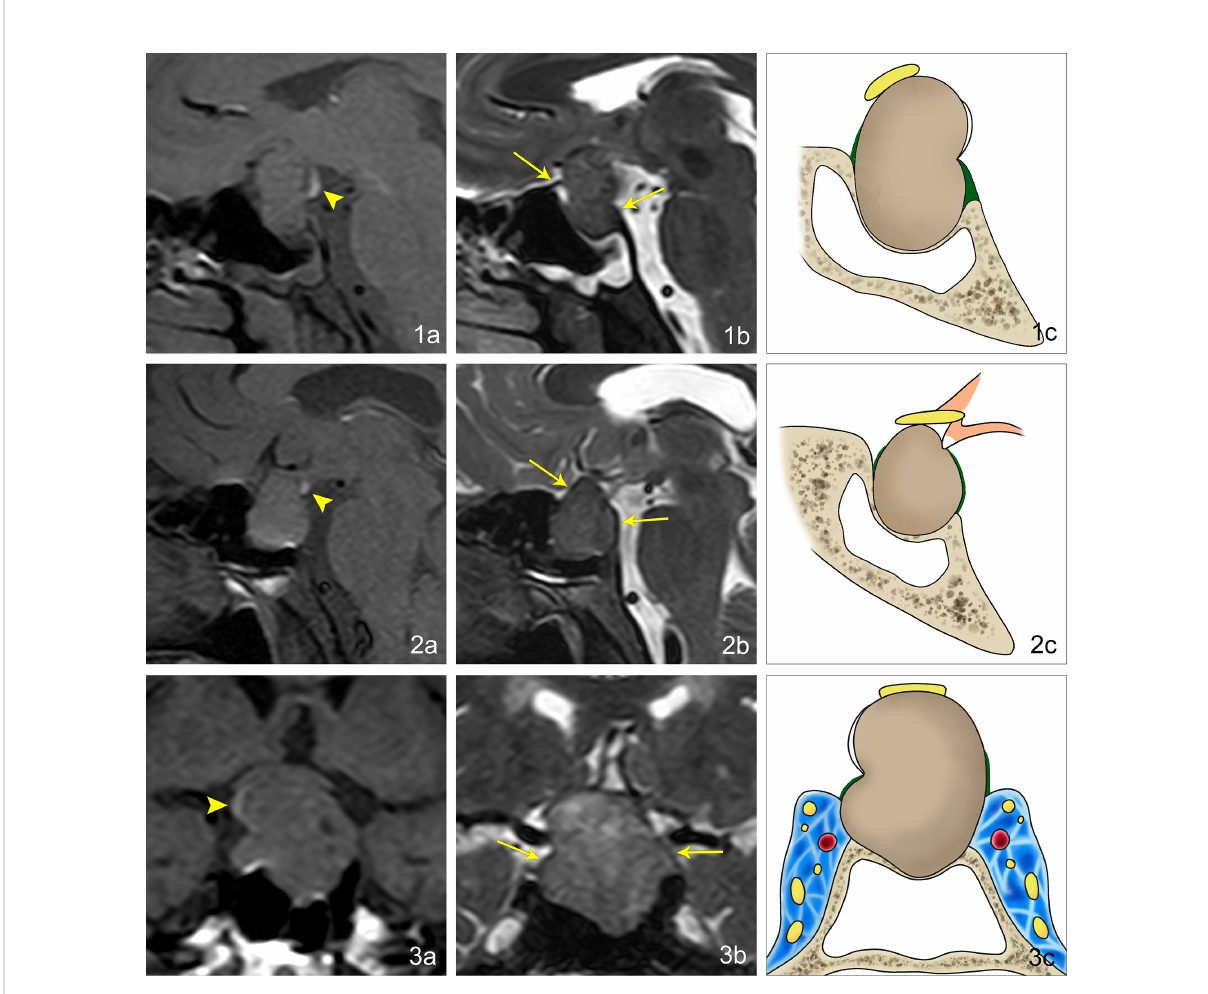
FIGURE 1 Imaging manifestations of EPPHS at different positions in pituitary macroadenoma. (1A) Sagittal T 1 WI reveals that EPPHS is arc-shaped and hyperintense, which is located at the posterior upper edge of pituitary macroadenoma (arrowhead). (1B) Sagittal T 2 WI reveals that the residual sellar septum at the anterior and posterior edges of pituitary macroadenoma is a strip-shaped hypointense signal (arrow). (1C) Pattern diagram reveals that the arc-shaped white structure is EPPHS, the brown structure is the pituitary macroadenoma, the yellow structure is the optic nerve, the green structure is the sellar septum, and the yellow-gray structure is the sella turcica. (2A) Sagittal T 1 WI reveals that EPPHS is nodular and hyperintense, which is located at the distal end of the pituitary stalk (arrowhead). (2B) Sagittal T 2 WI reveals that the residual sellar septum at the anterior and posterior edges of the pituitary macroadenoma is the strip-shaped hypointense signal (arrow). (2C) Pattern diagram reveals the arc- shaped white structure is EPPHS, the orange structure is the hypothalamus and pituitary stalk, the brown structure is the pituitary macroadenoma, the yellow structure is the optic nerve, the green structure is the sellar septum, and the yellow-gray structure is the sella turcica. (3A) Sagittal T 1 WI reveals that EPPHS is arc-shaped and hyperintense, which is located at the right margin of pituitary (arrowhead). (3B) Sagittal T 2 WI reveals that the residual sellar septum at the left and right edges of the pituitary macroadenoma is a strip-shaped hypointense signal (arrow). (3C) Pattern diagram reveals the arc-shaped white structure is EPPHS, the brown structure is the pituitary macroadenoma, the yellow structure is the optic nerve, the green structure is the sellar septum, the yellow-gray structure is the sella turcica, and the blue area is the cavernous